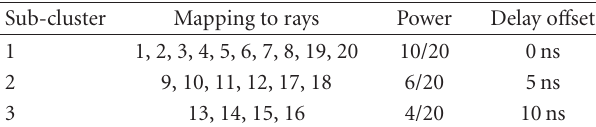
Table 1: Subcluster information for intracluster delay spread clusters.